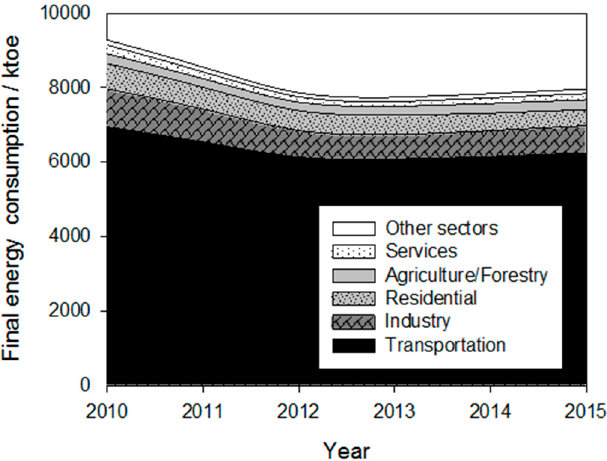
Figure 5. Evolution of oil products’ final energy consumption in Portugal by activity sector from 2010 to 2015 (data taken from [27]).